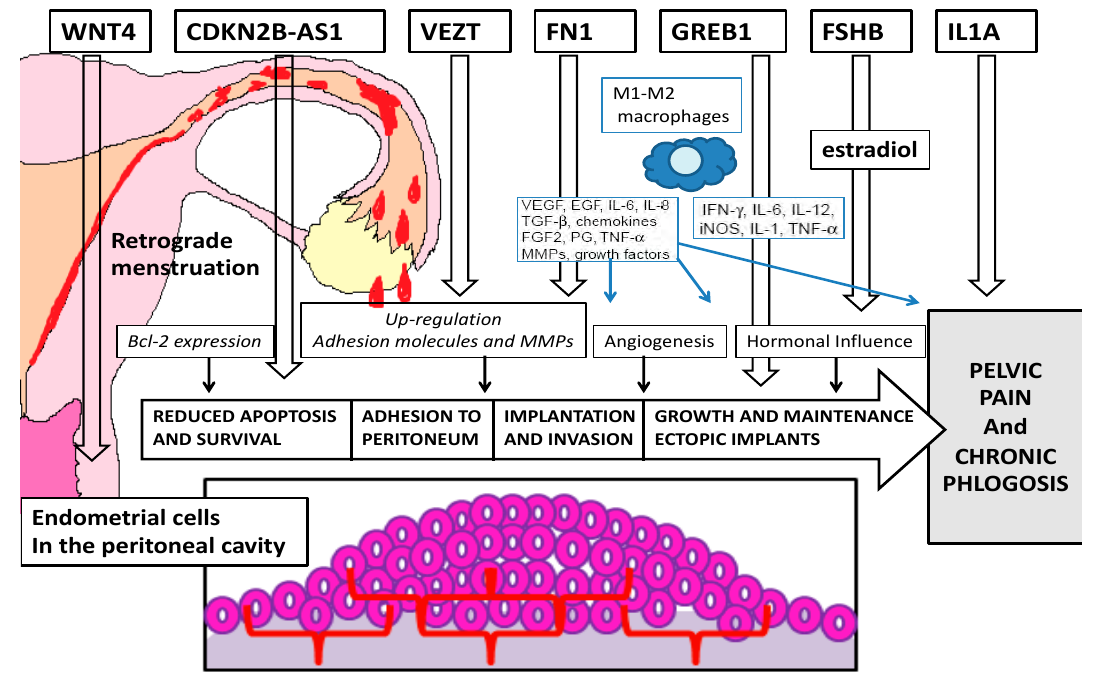
Figure 4. Pathogenetic targets of the most important genes related to endometriosis.